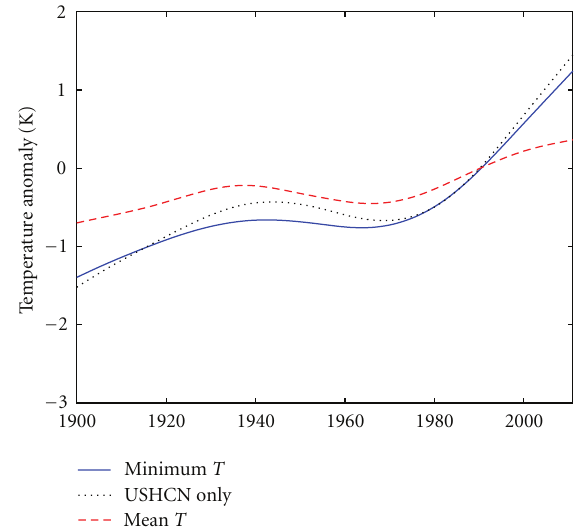
Figure 7: Annual minimum temperature trend (anomaly relative to the 1976–2005 mean) over the coterminous USA, compared to (1) the annual minimum temperature trend computed using only USHCN stations, (2) the trend in annual mean temperature.